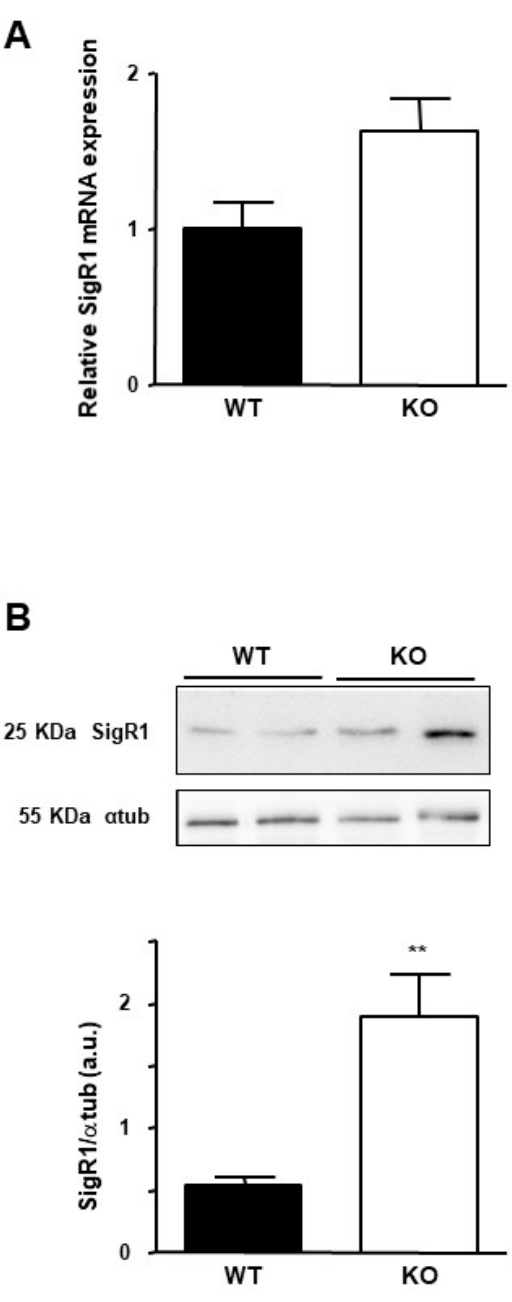
Figure 5. Effect of HNF1 α mutation on the expression of the SigR1. ( A ) mRNA expression of SigR1 by qPCR and ( B ) Protein expression of SigR1 by Western Blot on liver samples from Knock out (KO, n = 10) and Wild Type (WT, n = 9) HNF1 α mice. p = 0.0028. Data are shown as mean ± SEM, t-Test. ** p < 0.01, More details of western blots, please view at the supplementary materials.